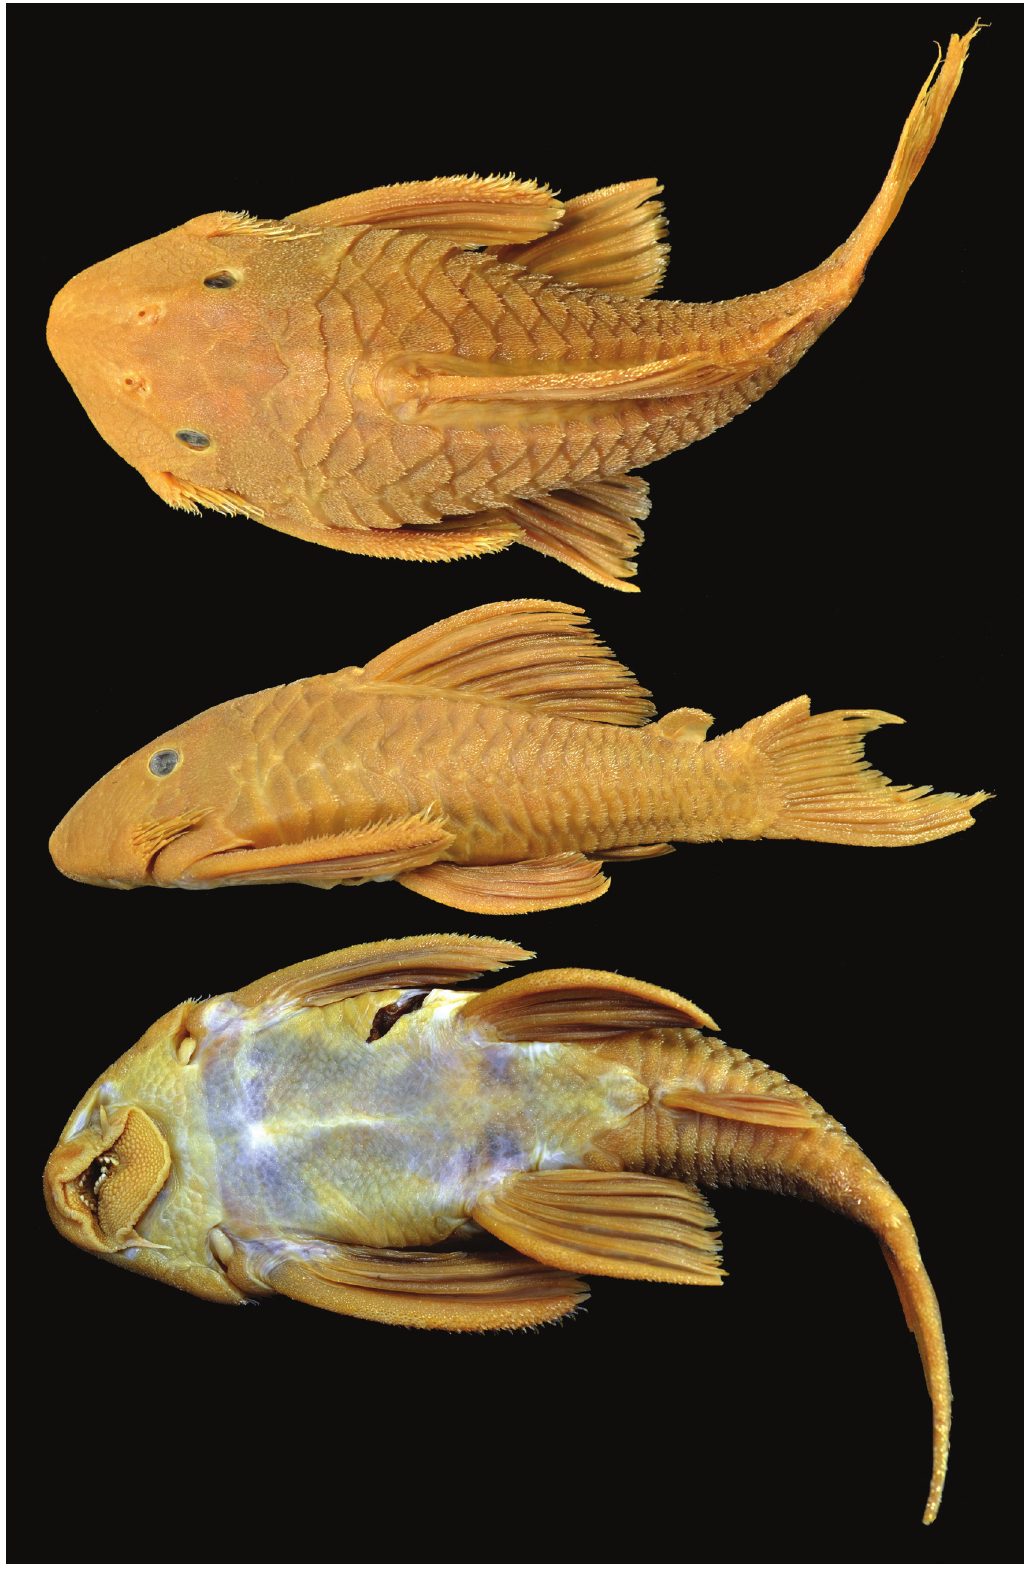
Fig. 2. Dorsal, lateral, and ventral views of Panaqolus purusiensis , holotype, AMNH 12600, 106.7 mm SL, Brazil, Acre, Purus drainage, vicinity of the mouth of rio Macauã, a tributary of rio